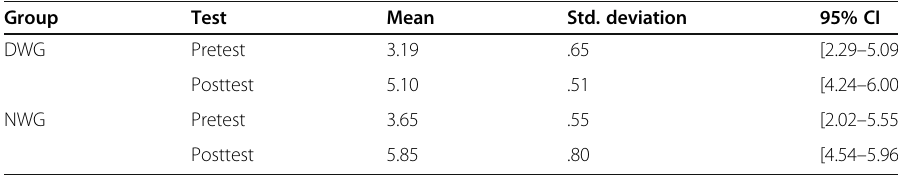
Table 8 Descriptive statistics: pretest and posttest scores Group Test Mean Std. deviation